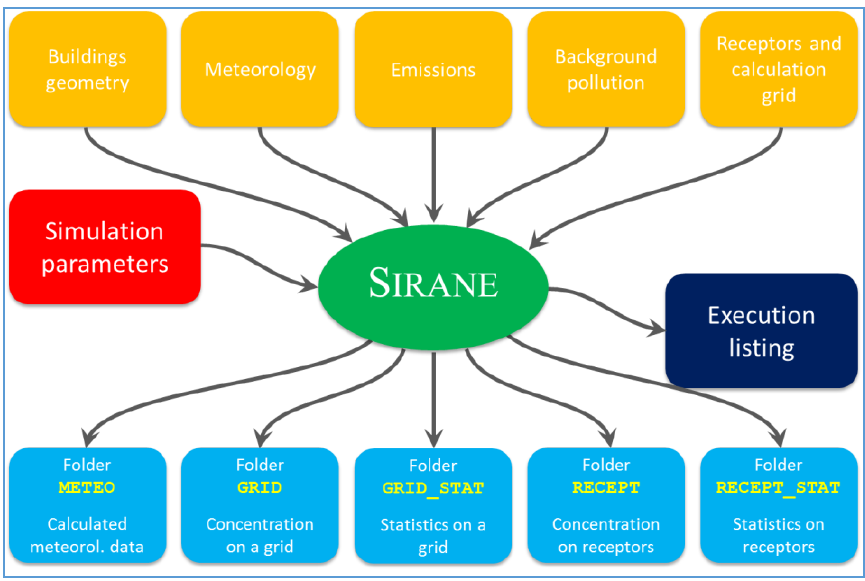
Figure 2. Map of the distribution of tubes with city boarders (elaboration by means of QGIS 2.18).